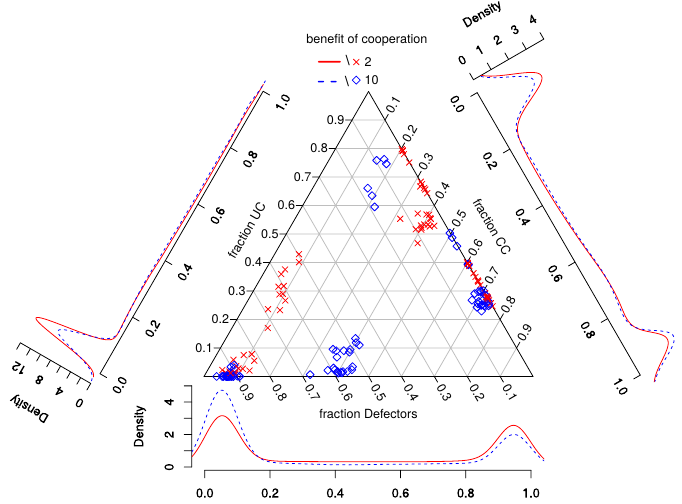
Figure 3. Distribution of the fraction of strategies across all simulations (density plots) and the per world mean fraction of strategies (points in simplex).